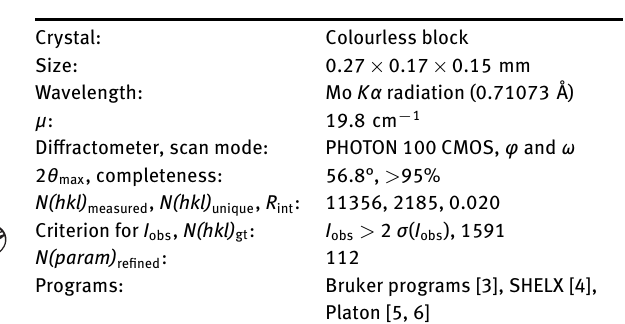
Table 1: Data collection and handling.